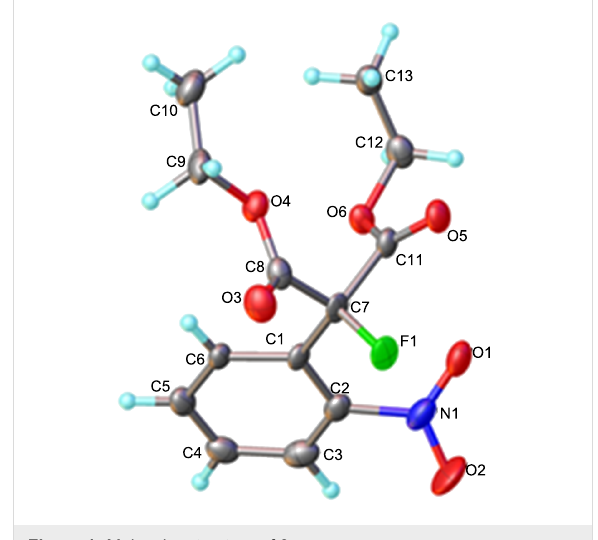
Figure 1: Molecular structure of 3